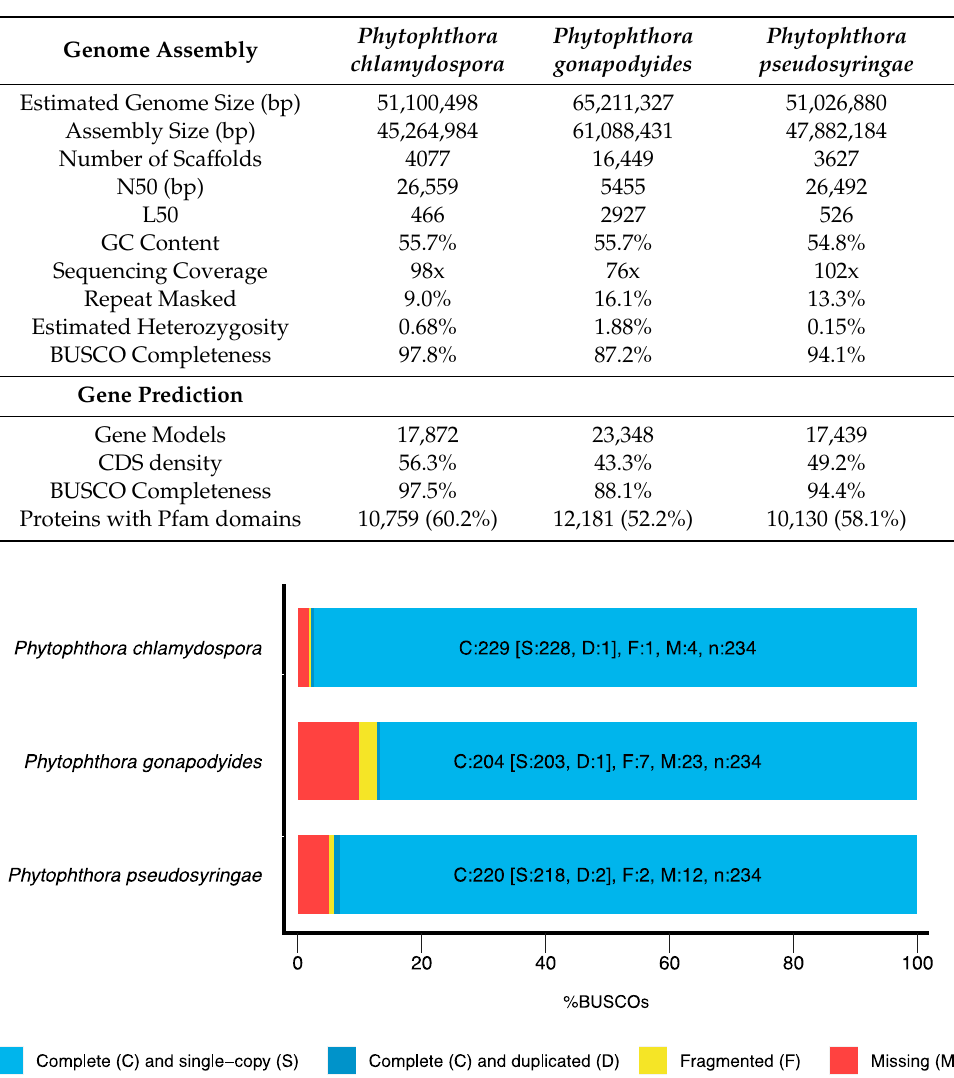
Figure 1. BUSCO analysis of Ph. chlamydospora , Ph. gonapodyides , and Ph. pseudosyringae using the Alveolata-Stramenopiles dataset. BUSCO completeness in all three species is high (97.8%, 87.2% and 94.1%) indicating that the genome assemblies are of high gene space completeness. The lower level of BUSCO completeness in Ph. gonapodyides is most likely the result of a fragmented assembly due to high levels of heterozygosity. Table 2. Genome assembly statistics.